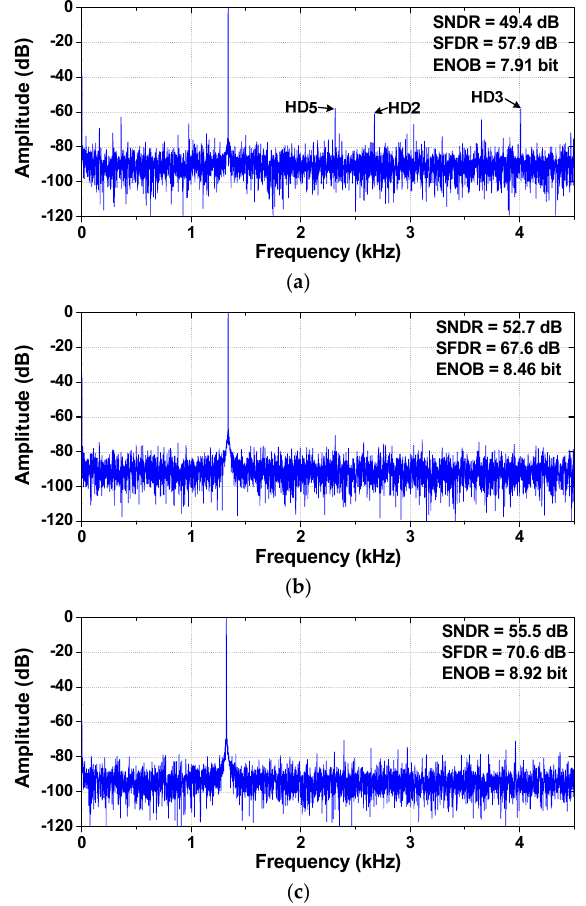
Figure 21. Measured output spectra of the ADC. ( a ) Before calibration, ( b ) after comparator offset calibration, and ( c ) after both comparator offset and DAC capacitor mismatch calibrations. f S = 9 kS/s, f IN = 1.32